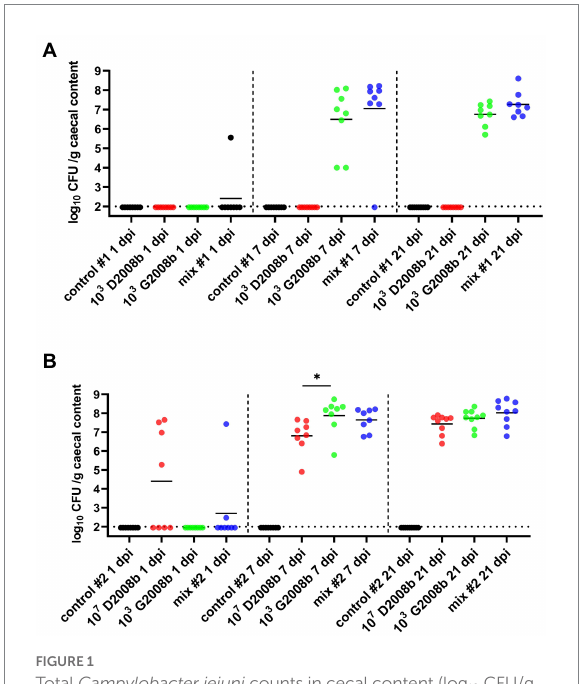
FIGURE 1 Total Campylobacter jejuni counts in cecal content (log 10 CFU/g of cecal content) from birds at 1, 7, and 21 dpi for room 1 (A) and room 2 (B) . Dots correspond to individual birds. Horizontal bars represent median values, and horizontal dotted lines denote the limit of detection (2 log 10 CFU/g of cecal content). Due to the low number of birds colonized at 1 dpi, statistical analyses were not performed. At 7 dpi and 21 dpi, statistical analyzes were conducted using a Mann–Whitney test (A) and a Kruskal-Wallis test followed by Dunn’s post-hoc tests with Bonferroni adjustments (B) to compare median values between colonized groups according to the time point and room. * indicates p <0.05.